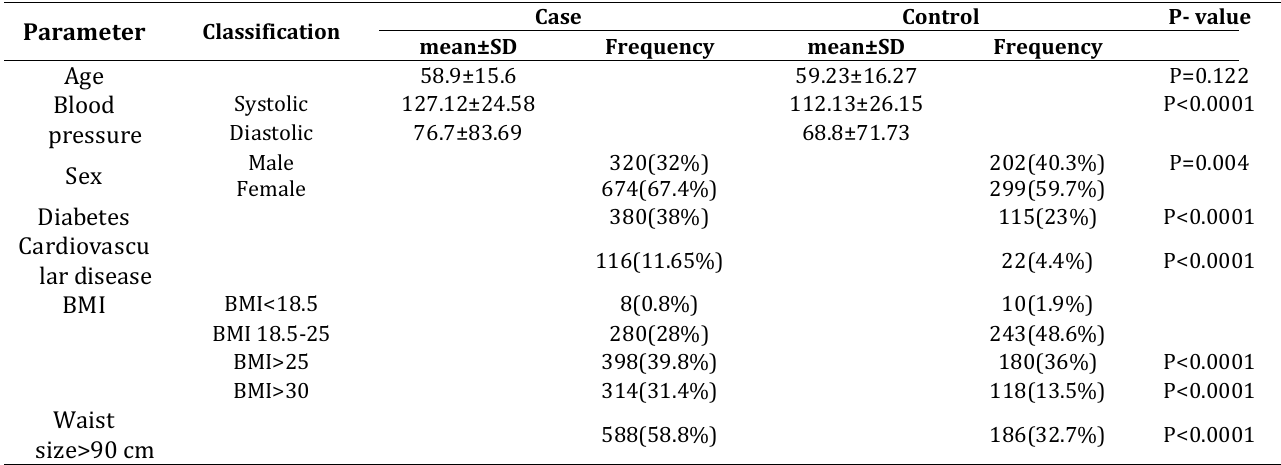
Table 1. Demographic characteristics of participants and its relation with hypertension